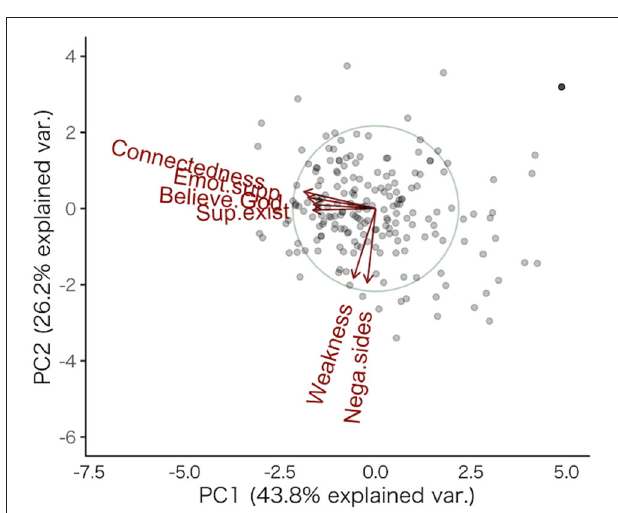
( β = 0.158, SE = 0.070, p = 0.025). Details of the results of